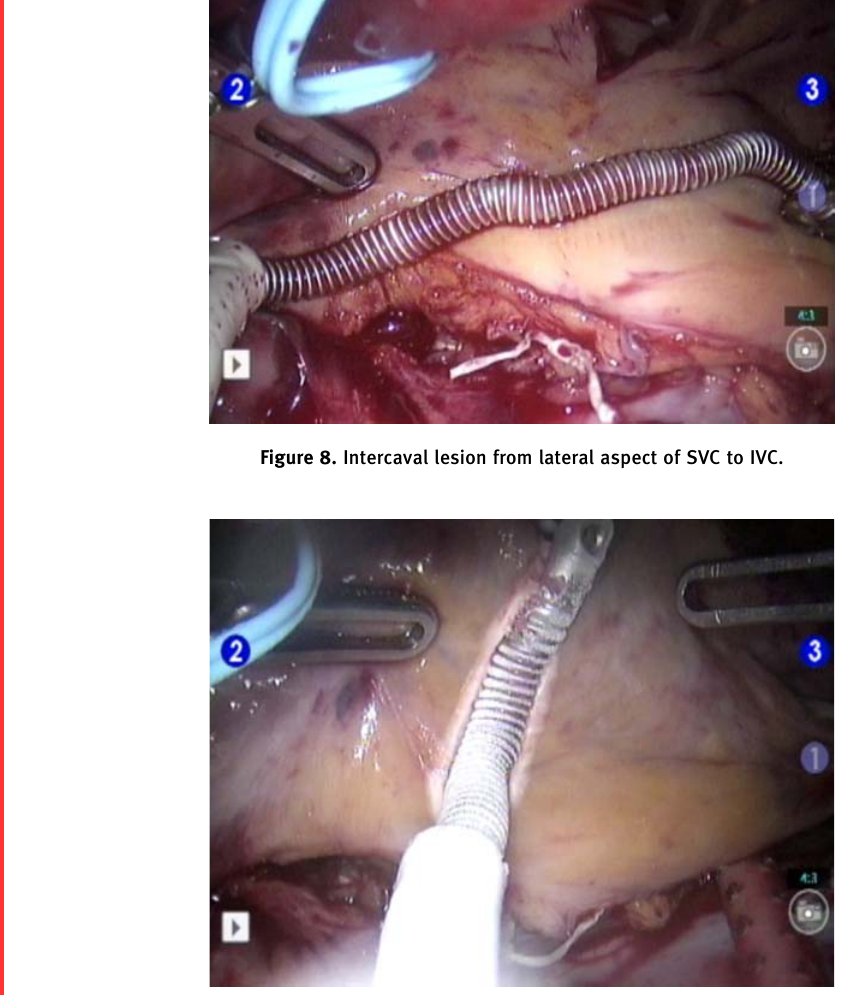
Figure 9. Lesion connecting right atriotomy to intercaval